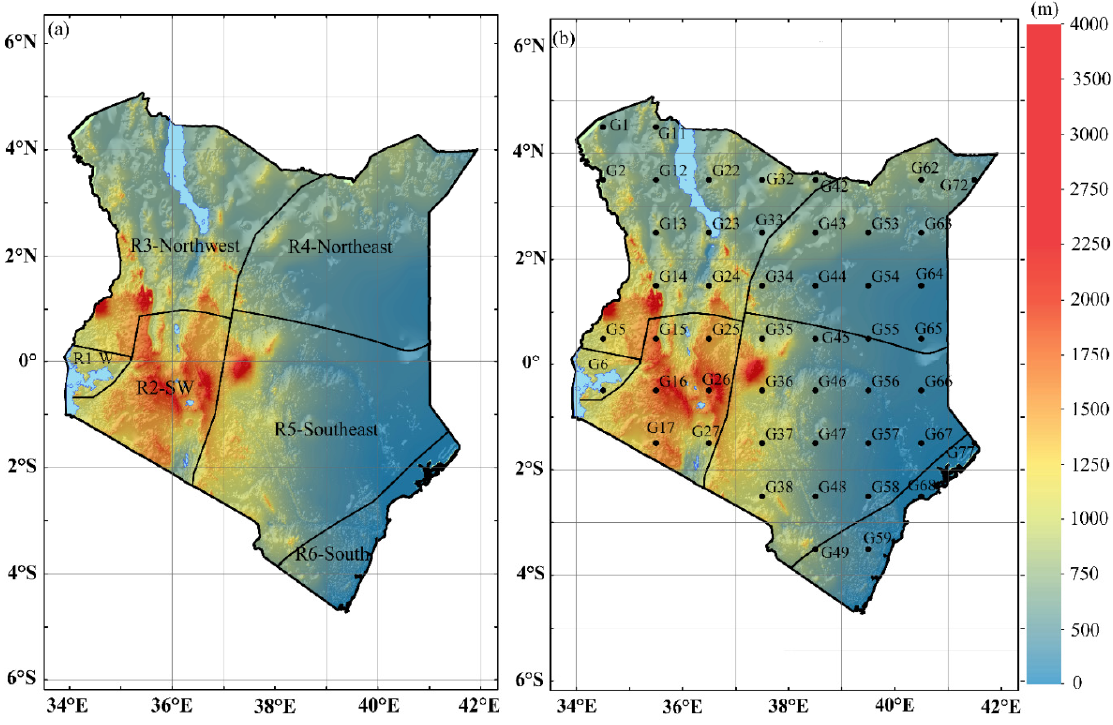
Figure 1. Elevation of the study area with distinct homogeneous locations, as delineated by Indeje et al. [58] and the respective grid cells in each region.